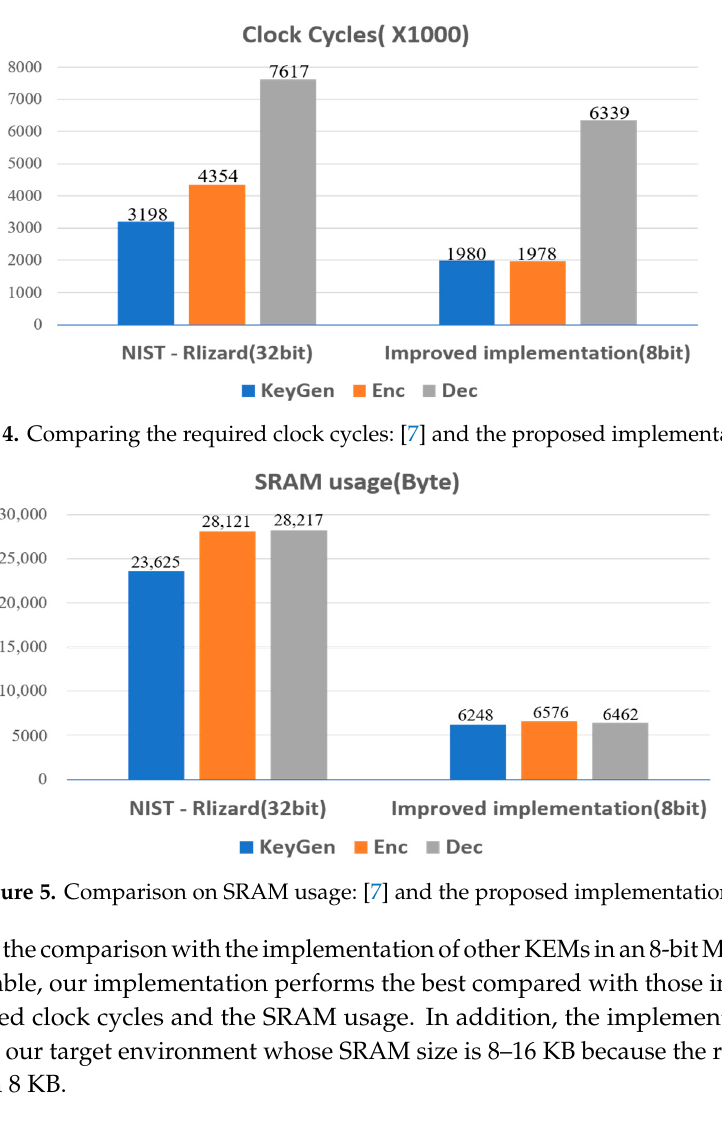
Table 5. Comparison with other implementations.